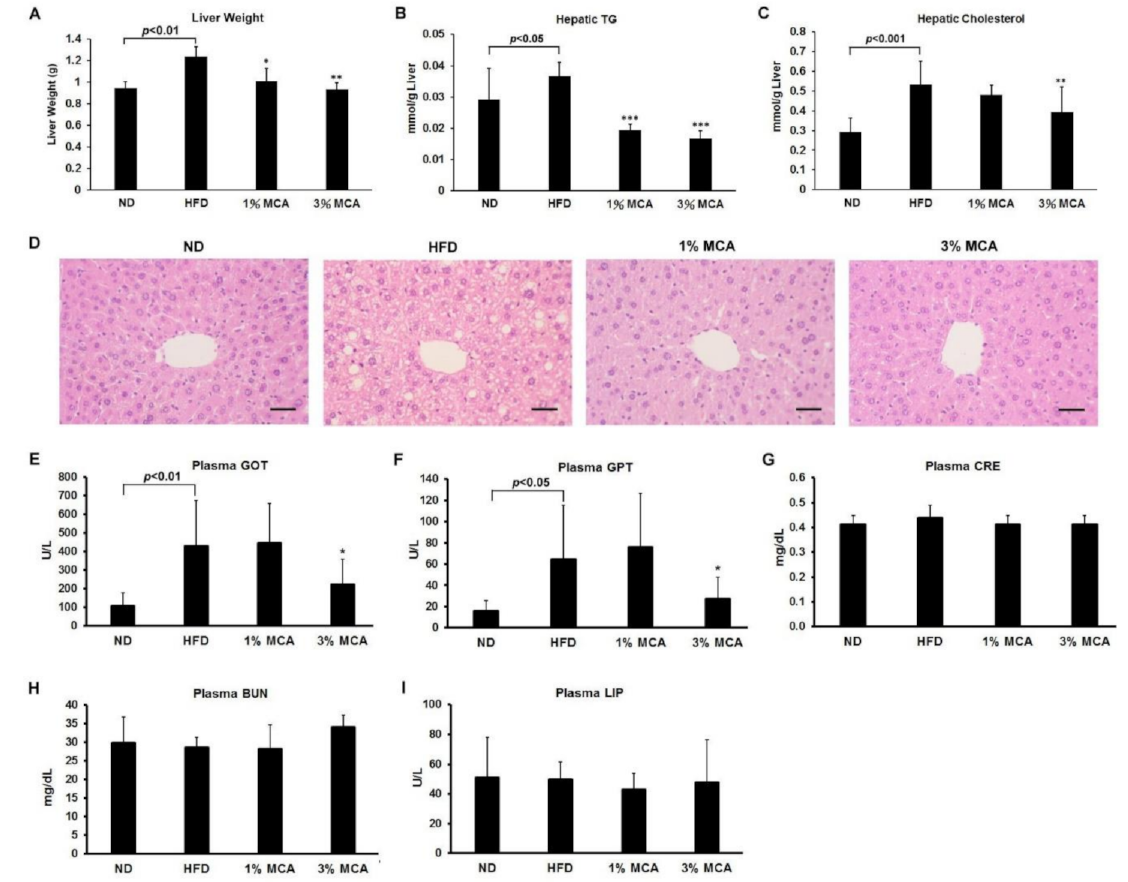
Figure 4. The effect of MCA on lipid accumulation in the liver and hepatic steatosis-related markers in HFD-fed mice. ( A ) Liver weight, ( B ) hepatic TG level, ( C ) hepatic cholesterol, ( D ) hematoxylin and eosin staining of hepatocytes (original magnification × 200), ( E ) glutamic oxaloacetic transaminase (GOT), ( F ) glutamic pyruvic transaminase (GPT). The plasma levels of the kidney lipotoxicity markers ( G ) creatinine (CRE), and ( H ) blood urea nitrogen (BUN). ( I ) The plasma levels of the pancreas lipotoxicity marker lipase (LIP). The scale bar is 100 µ m. Data are shown as means ± SEM. HFD vs. MCA, * p < 0.05; ** p <